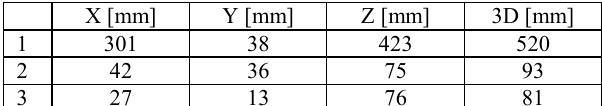
Table 2. Deviations of direct georeferencing and bundle adjustment